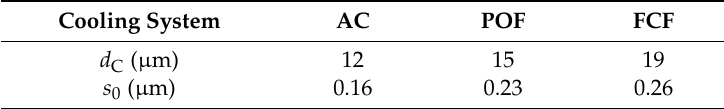
Table 1. Microstructural parameters as a result of the cooling